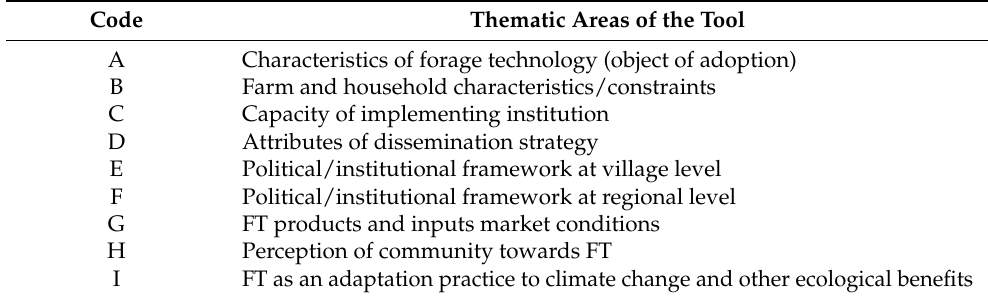
Table 1. Thematic categories of QATo-FT. Code Thematic Areas of the